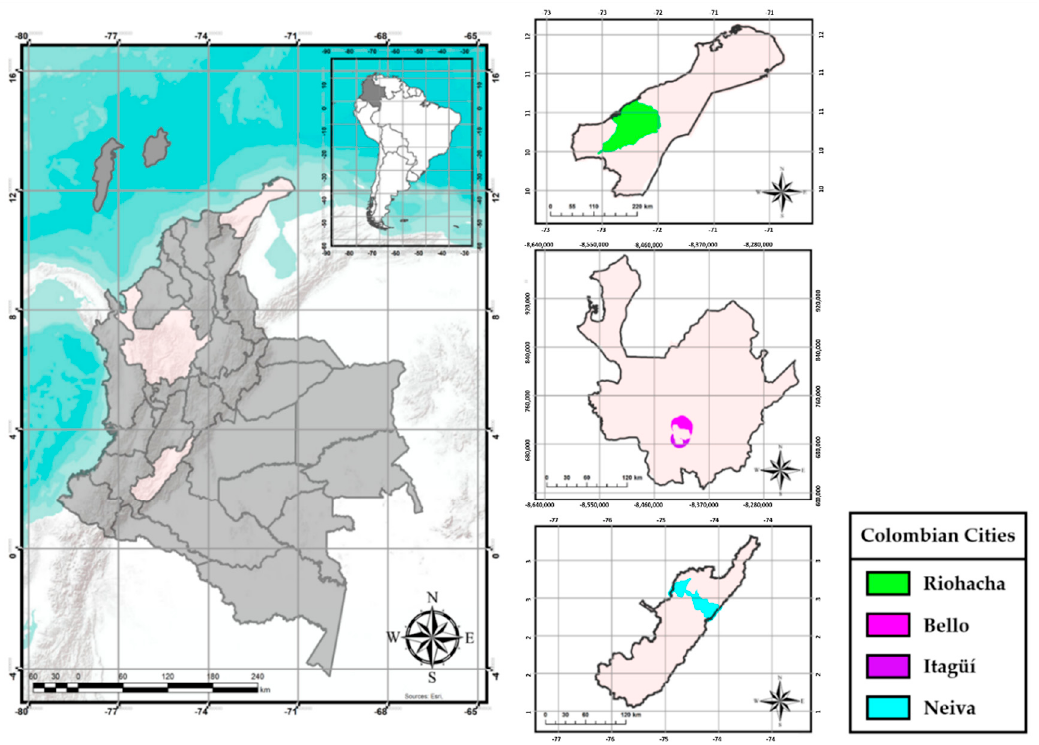
Figure 1. Map of Colombia showing cities where samples of Aedes aegypti mosquitoes were